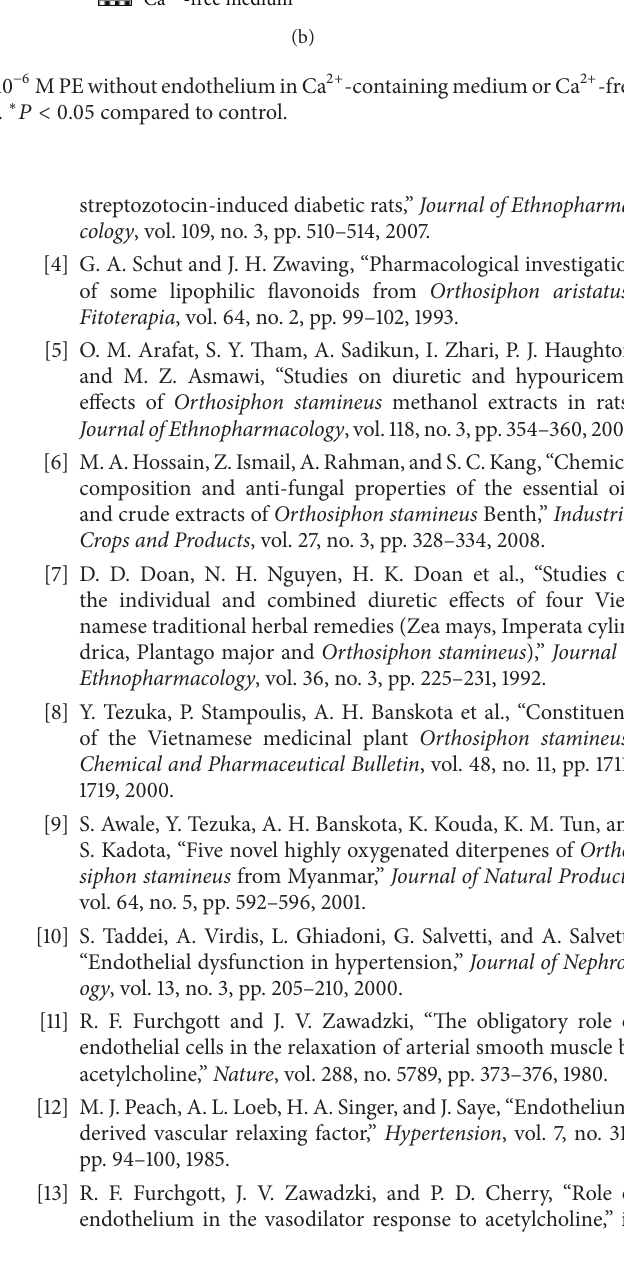
Figure 5: Histograms showing the mean of the response induced by 10 −6 M PE without endothelium in Ca 2+ -containing medium or Ca 2+ -free medium. Results are expressed as mean ± SEM of 6 experiment sets. ∗ 𝑃 < 0.05 compared to control.